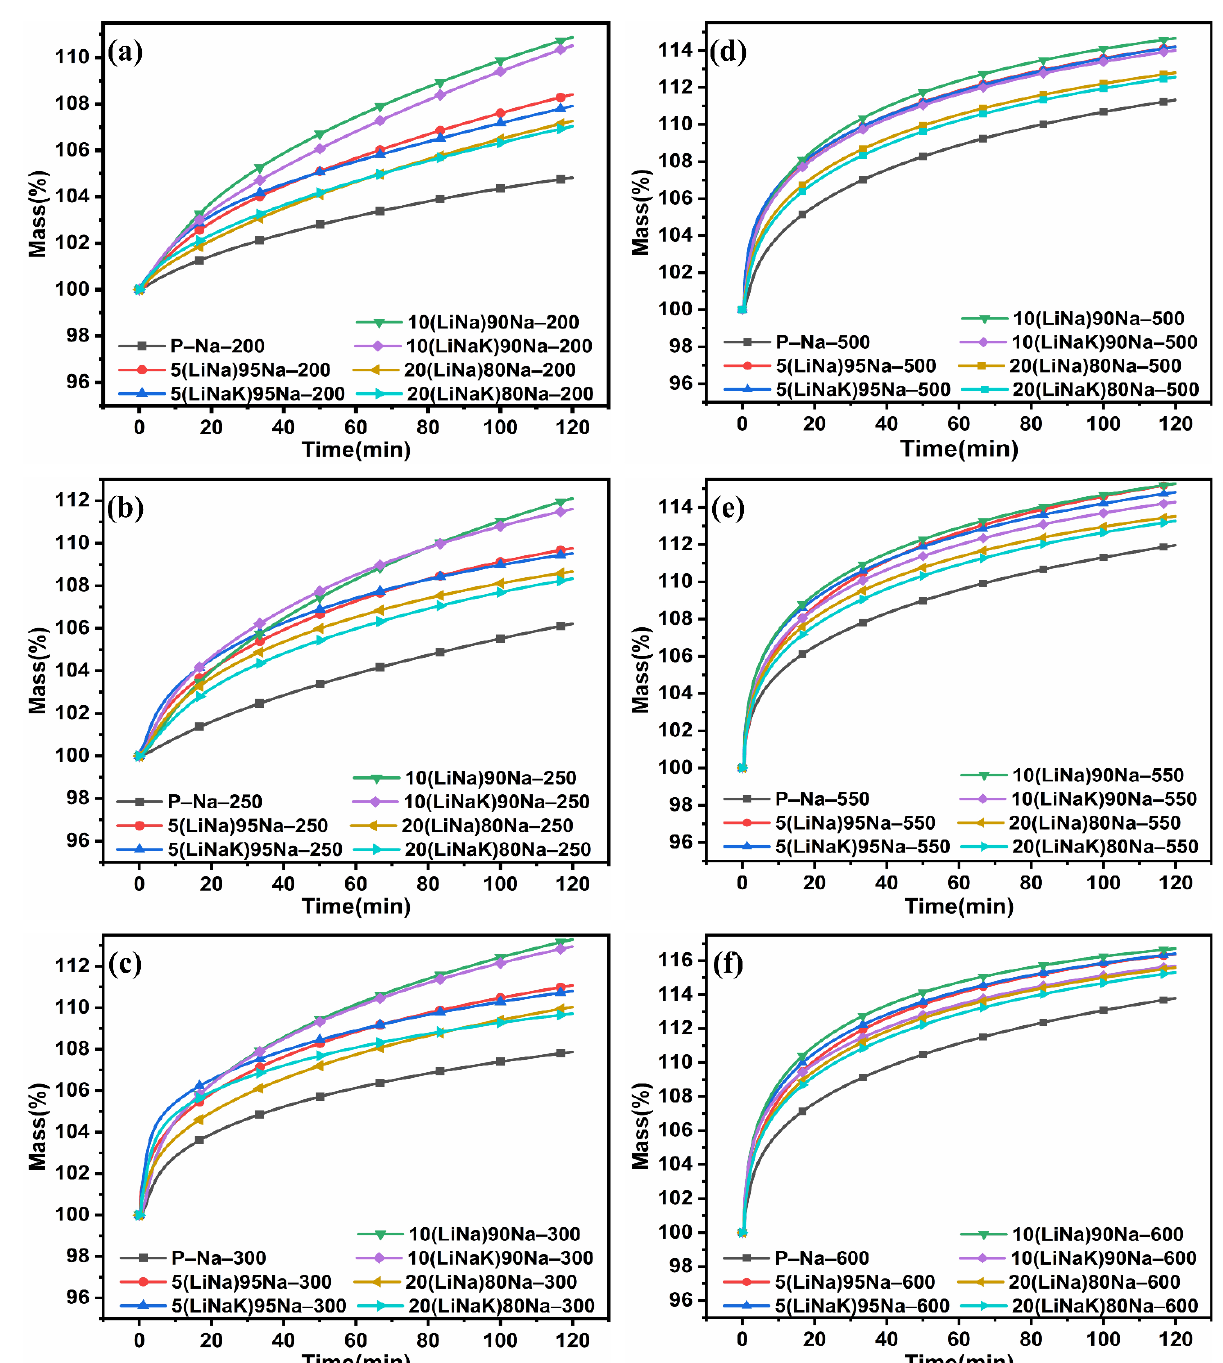
Figure 5. Isothermal analyses of Na 4 SiO 4 with different carbonates at ( a – c )200–300 °C and ( d – f )500–600 °C in the atmosphere containing 80% CO 2 . Table 1. Kinetic parameters of P–Na, 10(LiNa)90Na, and 20(LiNa)80Na at 200–300 °C.